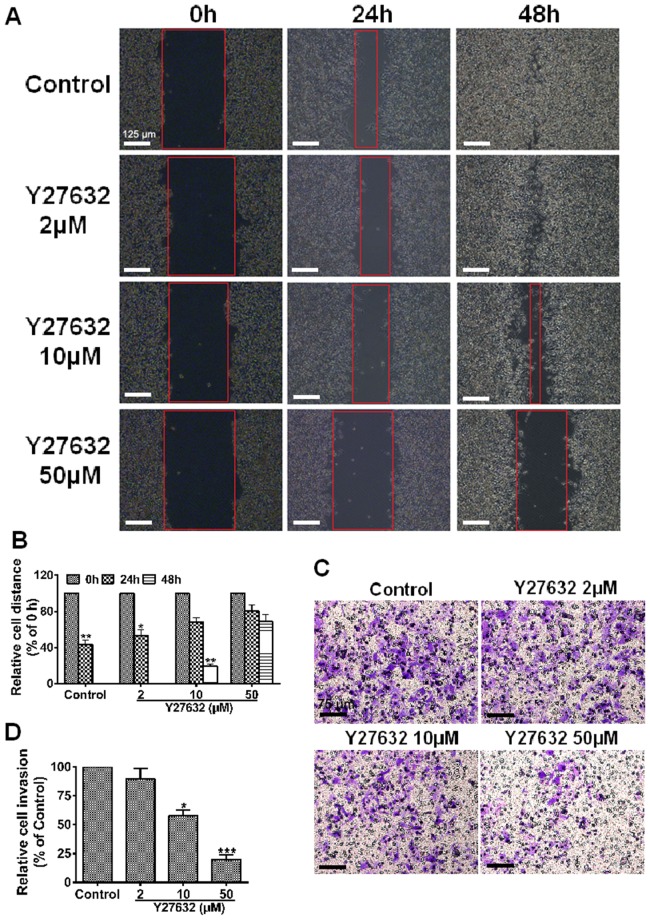
ROCK inhibition decreases the motility of MHCC97H cells.(A) Y27632 inhibition delayed wound healing. Representative images of scratch wounds formed at 0, 24 and 48 h after wounding. Original magnification was 100×, scale bars represent 125 µm. (C) Y27632 inhibition decreased invasiveness. Invaded cells attached at the lower surface of the filters were stained with crystal violet. Original magnification was 200×, scale bars represent 75 µm. (B) and (D) Data were normalized to untreated cells and the relative migration or invasion is expressed as mean ± S.E. of triplicate experiments. Fewer cells migrated or invaded 48 h after incubation with Y27632 (50 µM), compared with the control cells, *P<0.05, **P<0.01 and ***P<0.001.